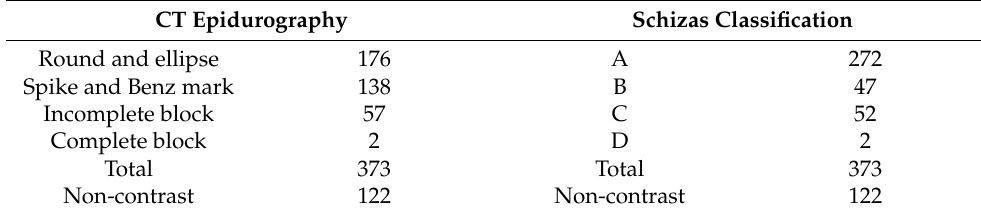
Table 5. Comparison of MRI and CT